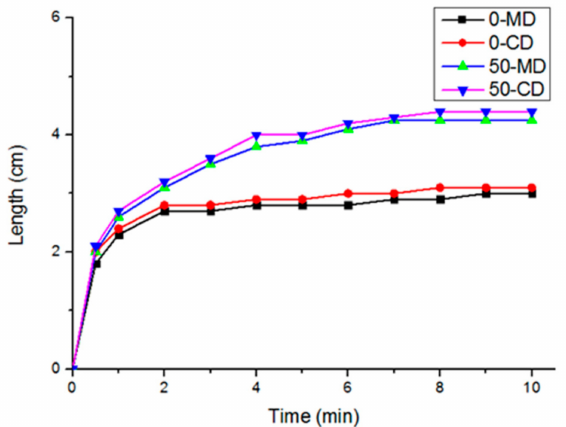
Figure 6. Dynamic curves of PT nonwoven composites as related to polyacrylate fiber content (0 and 50 wt %) and fiber orientation (MD and CD).